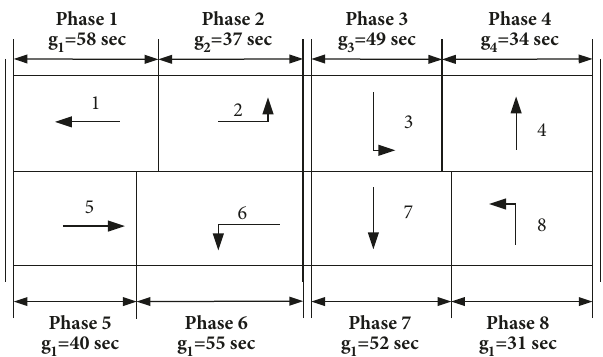
Figure 10: Optimized signal timing with transit signal